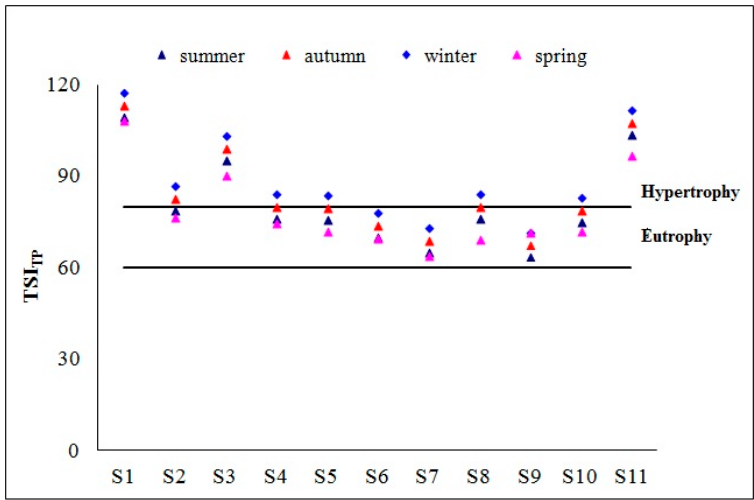
Figure 4. Seasonal trend of trophic state index (TSI TP ) determined with total phosphorus (TP).